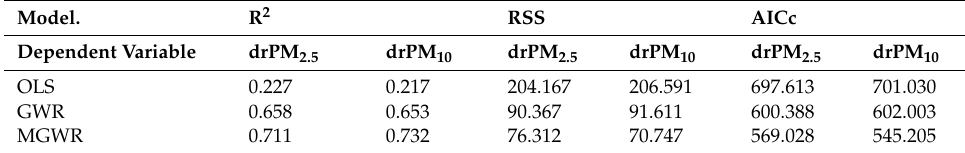
Table 6. Model performance of ordinary least square (OLS), geographically weighted regression (GWR), and multi-scale geographically weighted regression (MGWR).